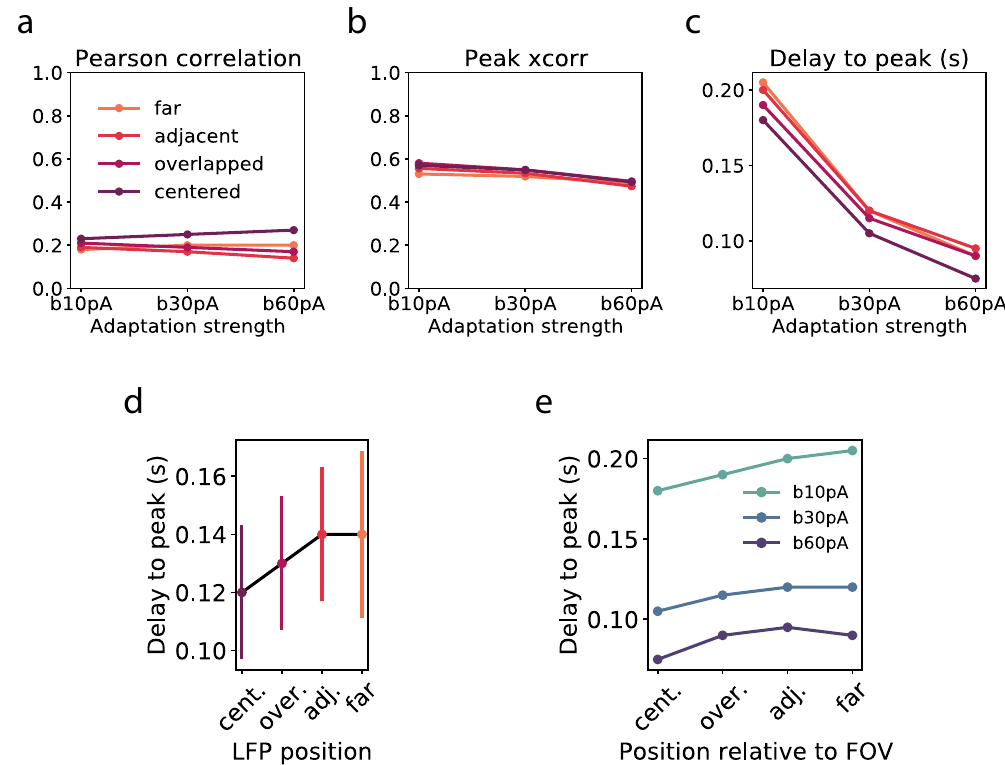
Figure 9. Correlation between calcium and LFP for each condition. a-c. Pearson’s correlation, peak cross- correlation and delay to peak as a function of the adaptation strength. Colors indicate the condition, that is the position of the LFP area with respect to the calcium area. d. Average across different adaptation strengths of the delay to peak as a function of the condition. Error bars indicate the standard error of the mean. e. In each adaptation strength, delay to peak as a function of the condition.